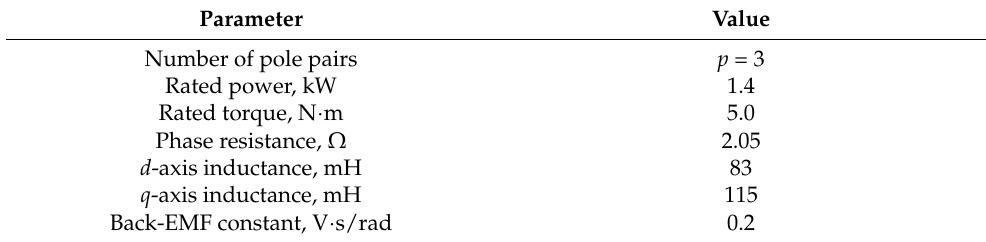
Table 1. Motor rated parameters.